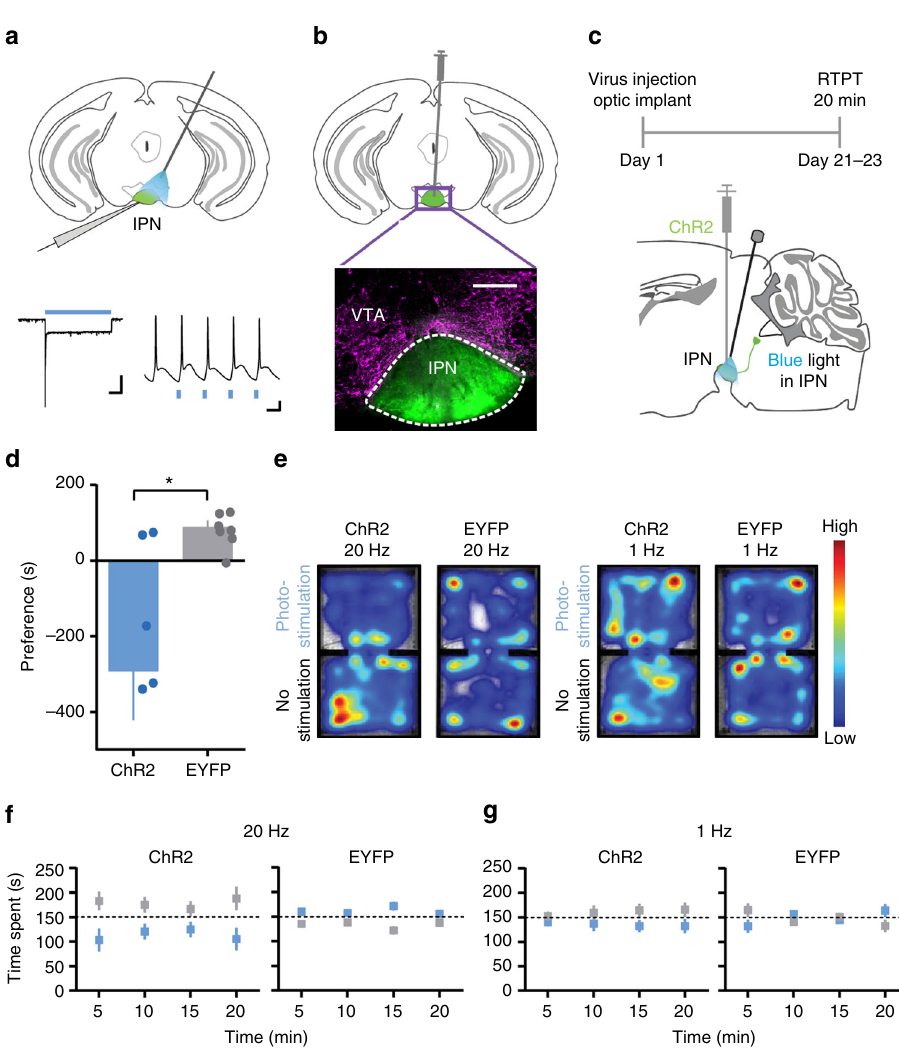
Fig. 1 Optogenetic activation of IPN neurons elicits place avoidance. a Upper: Schematic of recording set-up; lower: light-evoked current (1 s, 100 pA scale) and action potentials in IPN neurons (50 ms, 10 mV scale). b Fluorescent image of IPN ChR2 expression (green) and proximal VTA (magenta TH staining) (250 μ m scale). c Timeline and schematic of experimental set-up. d Preferences for photo-stimulation side vs. no stimulation side in RTPT with 20 Hz stimulation; unpaired t -test (two-tailed), t 12 = 2.922, P = 0.0128, n = 7 mice per group. e Representative heat maps of animal positions during 20 Hz and 1 Hz stimulation. f Time spent (5 min bins) on photo-stimulation side (blue box) and no-stimulation side (grey box) at 20 Hz and g at 1 Hz. Data presented as mean ± SEM, * P